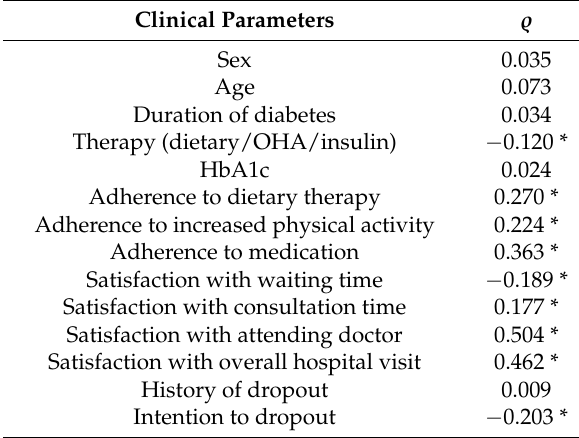
Table 3. Correlations between total DTSQ score and clinical parameters. This was modified and adopted from reference